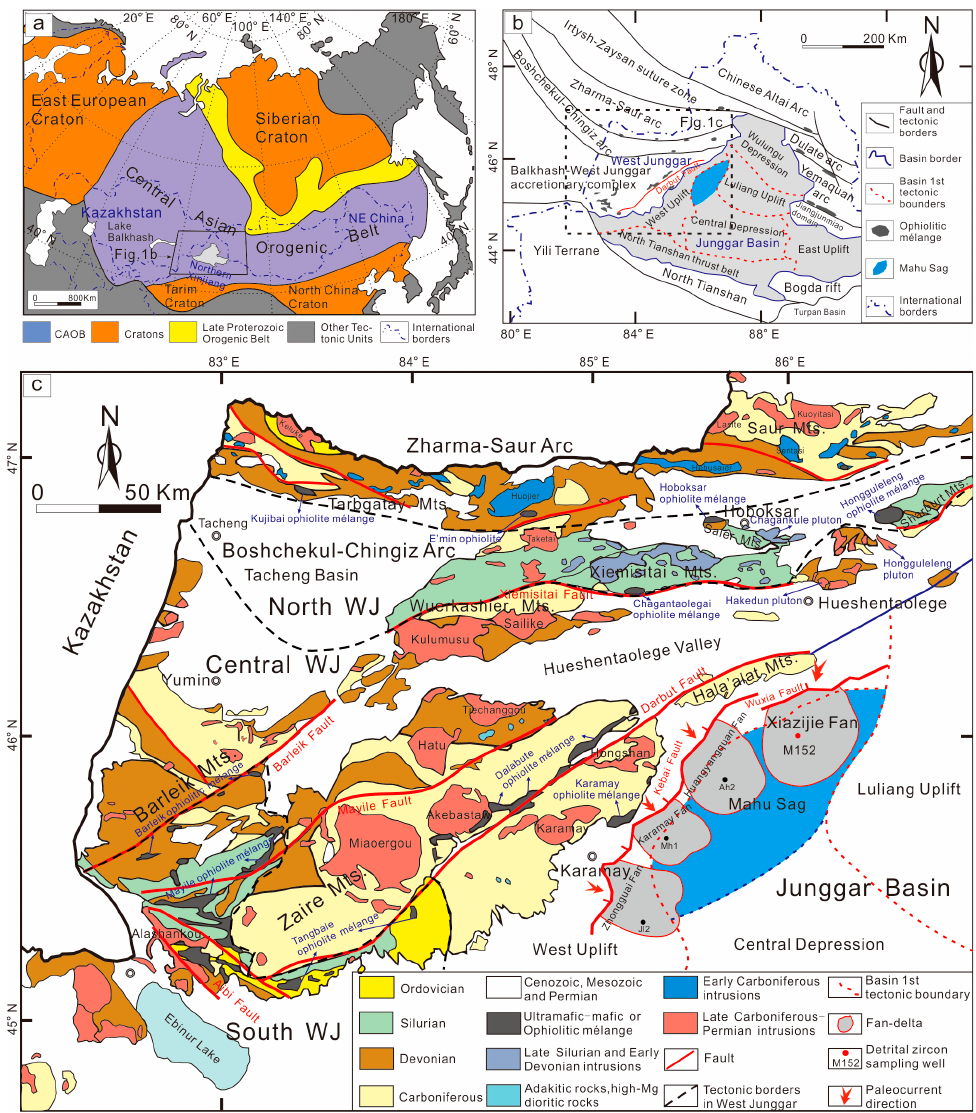
Figure 1. ( a ) Tectonic outline of the CAOB and environs, modified after reference [5]; ( b ) tectonic map showing the Junggar basin and adjacent regions, modified after references [5,6]; ( c ) Geological map of West Junggar and adjacent northwest margin of Junggar basin (modified after references [7,8]), showing the location of Mahu Sag and the distribution of several fan-deltas in the Triassic Baikouquan Formation. The paleocurrent direction of these fan-deltas are from references [3,4]. Abbreviations: CAOB: Central Asian Orogenic Belt; WJ: West Junggar. In the last ten years, U-Pb dating of detrital zircon was widely used to infer maximum depositional ages of sedimentary strata, search for the potential source areas of sediments and reconstruct paleogeography [9–11]. Compared with the traditional heavy mineral